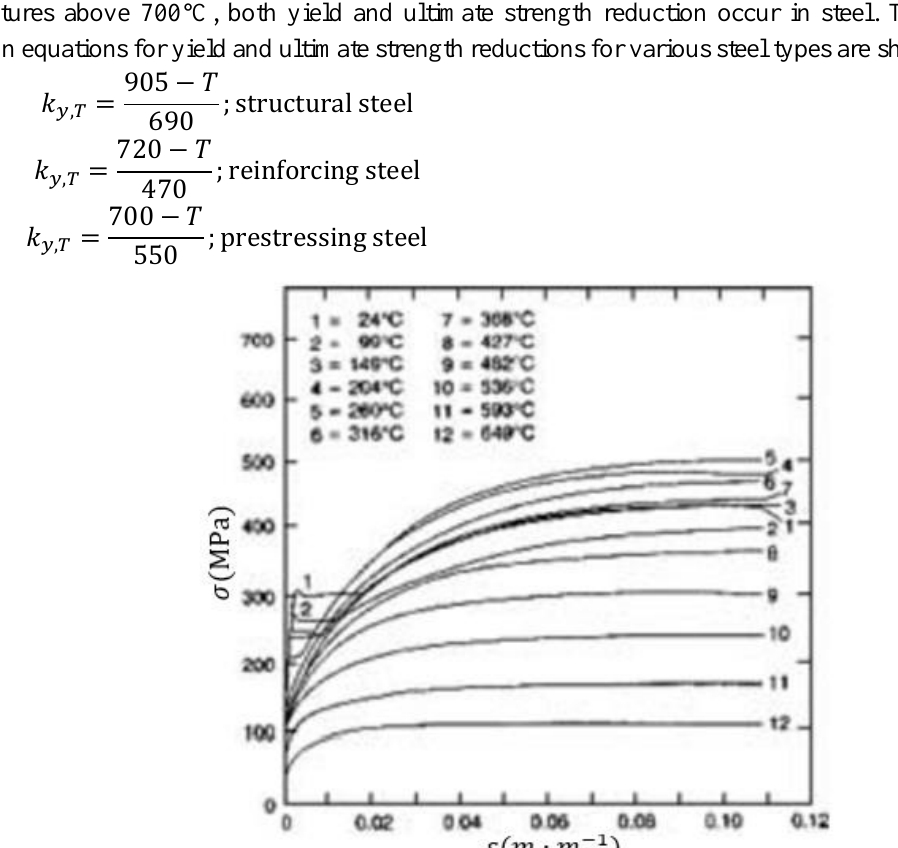
Figure 1. Strain-stress curvatures for hot rolled steel at high temperatures